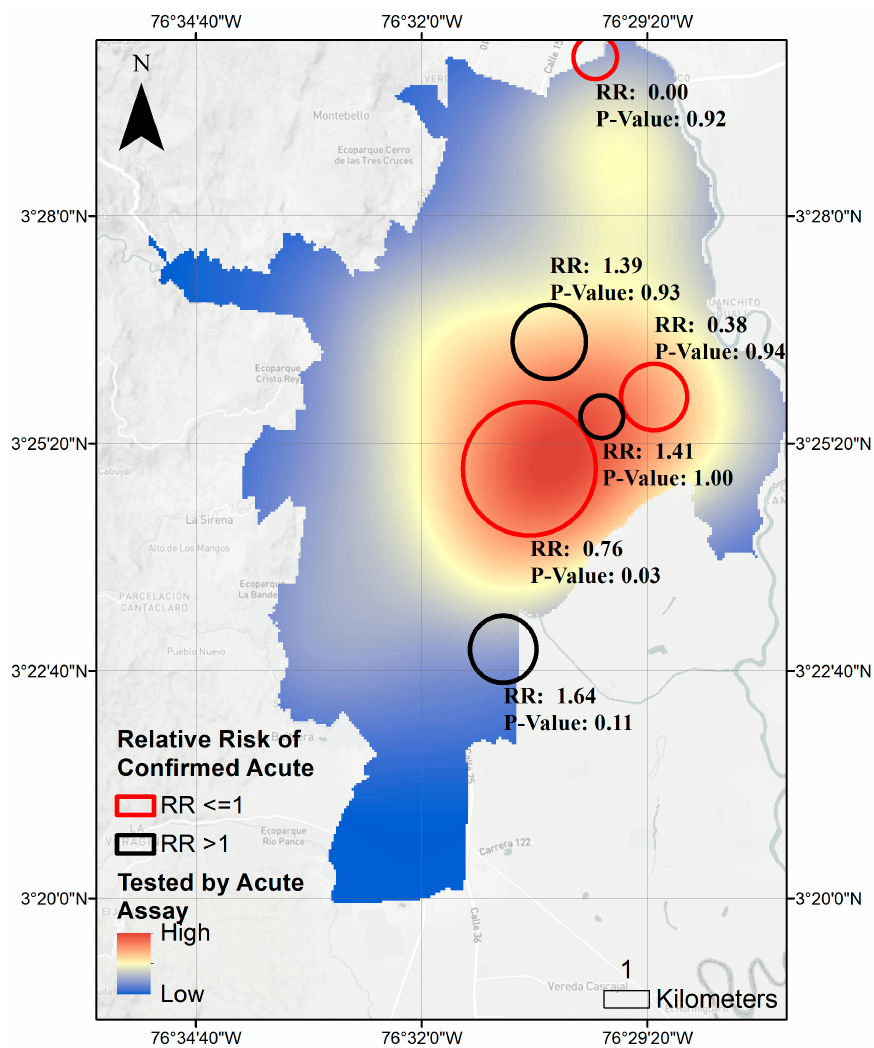
Figure 5. Spatial clustering of true DENV positives among acutely tested DENV cases reported to SIVIGILA in urban area of Cali, Colombia 2014–2016. RR = Relative Risk calculated as ratio of observed versus expected number of cases having lab a positive lab results compared to negative lab result among cases tested by lab for acute DENV infection in urban area of Cali, Colombia. Lower median neighborhood social strata (government assessed level of median neighborhood income level) and higher homicide risk is associated with higher burden of DENV ( p < 0.001, Table 2, Absolute Burden of DENV); lower rates of acute testing ( p < 0.001, Table 2, Access to DENV Laboratory Testing); and higher rates of discordance between lab diagnosis and clinically suspected DENV cases ( p < 0.001, Table 2, Discordance Between Lab and Clinician).